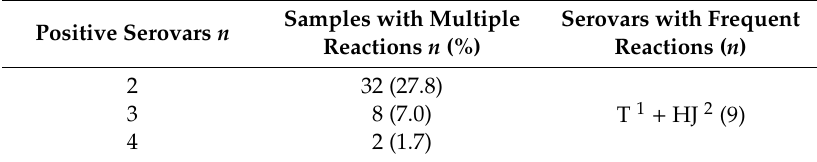
Table 3. Number and percentage of positive samples reacting with two, three or more serovars.